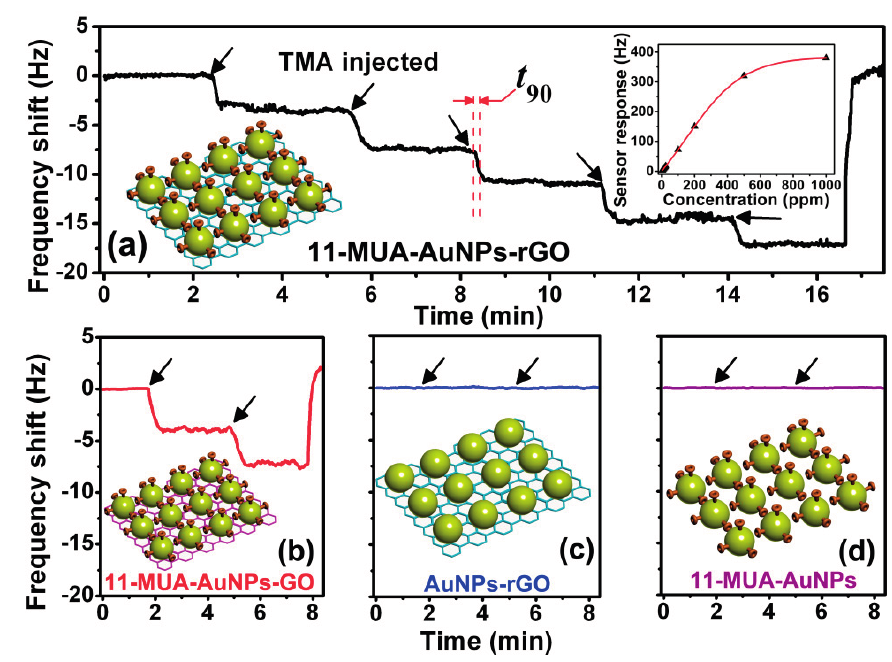
Figure 24. Measured frequency sensing signals to TMA vapors. The cantilever sensors are loaded with different sensing materials: ( a ) functionalized AuNPs-rGO; ( b ) functionalized AuNPs-GO; ( c ) AuNPs-rGO without functionalization; ( d ) functionalized AuNPs. The arrows denote the moments when stepwise-increased TMA vapors (increment is 5 ppm) are sequentially injected into the testing chamber. Reprinted with permission from